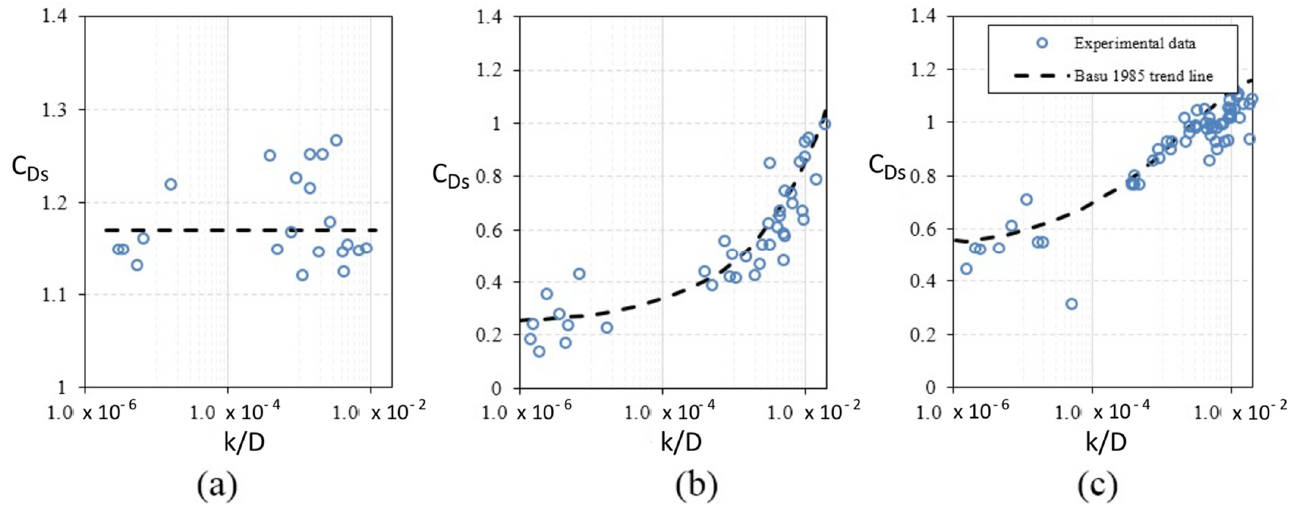
Figure 4. Variation of the mean drag coefficient with surface roughness ratio for ( a ) subcritical, ( b ) critical, and ( c ) post-critical ranges of Reynolds number (rebuilt with data from [46]).